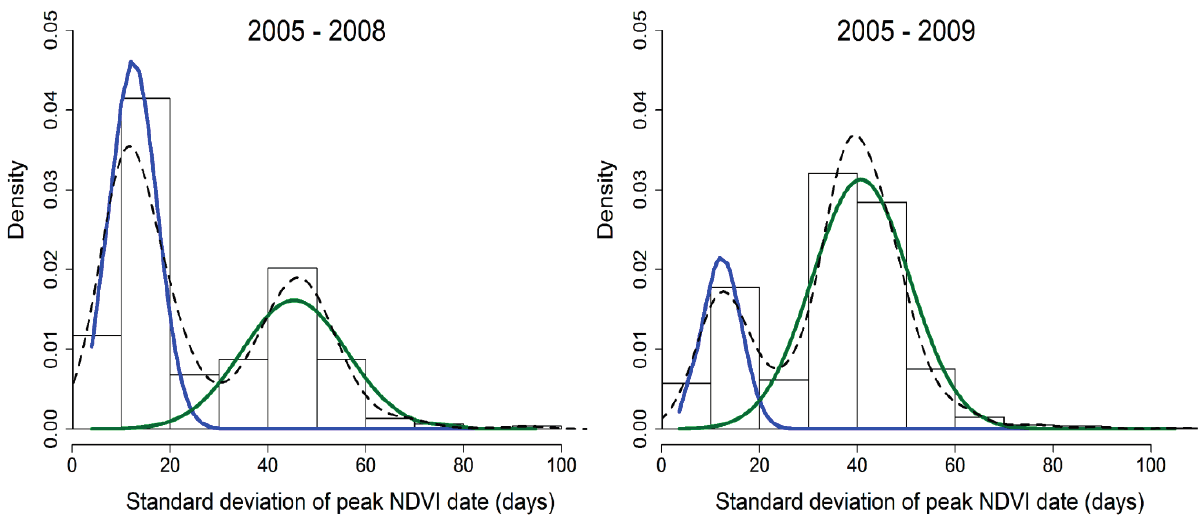
Figure 7. Frequency distributions of the variation in peak NDVI date for 2005–2008 ( left ) and 2005–2009 ( right ). The time periods were analyzed separately to assess the behavior of high/average precipitation years vs. those that include a drought year (2009). Individual Gaussian functions are shown in blue (monsoon) and green (post-monsoon); the dashed line represents the density function for the composite